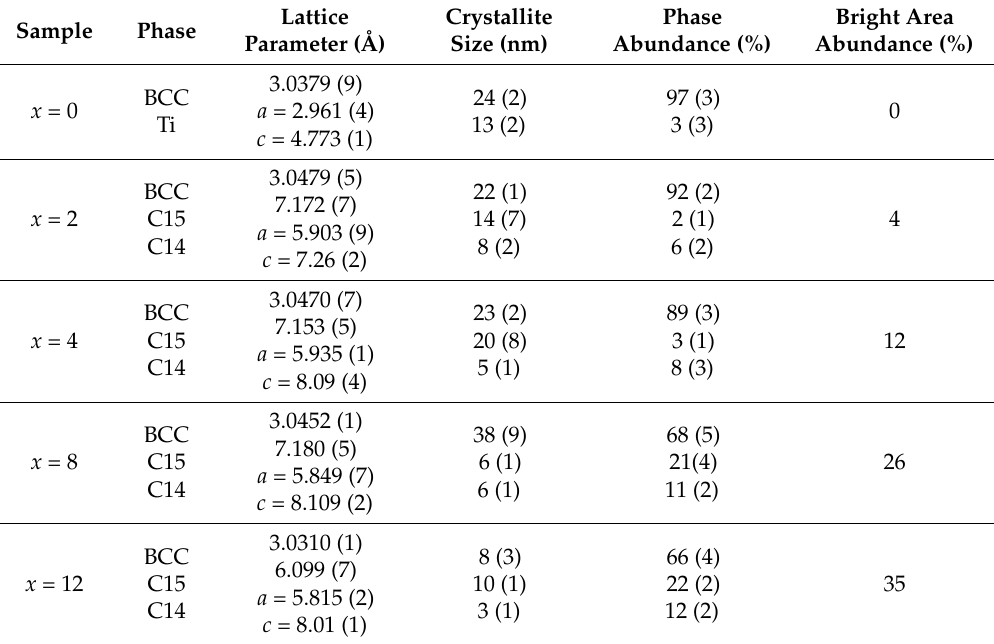
Figure 3. X-ray diffraction patterns of as cast: Ti 1 V 0.9 Cr 1.1 + x wt % Zr alloys with x = 0, 2, 4, 8, and 12. Table 6. Crystal parameters and abundance of each phase in as cast: Ti 1 V 0.9 Cr 1.1 + x wt % Zr alloys for x = 0, 2, 4, 8, and 12. Error on the last significant digit is indicated in parentheses. Phase Abundance Sample Phase Lattice Parameter (Å) Crystallite Size (nm) (%)